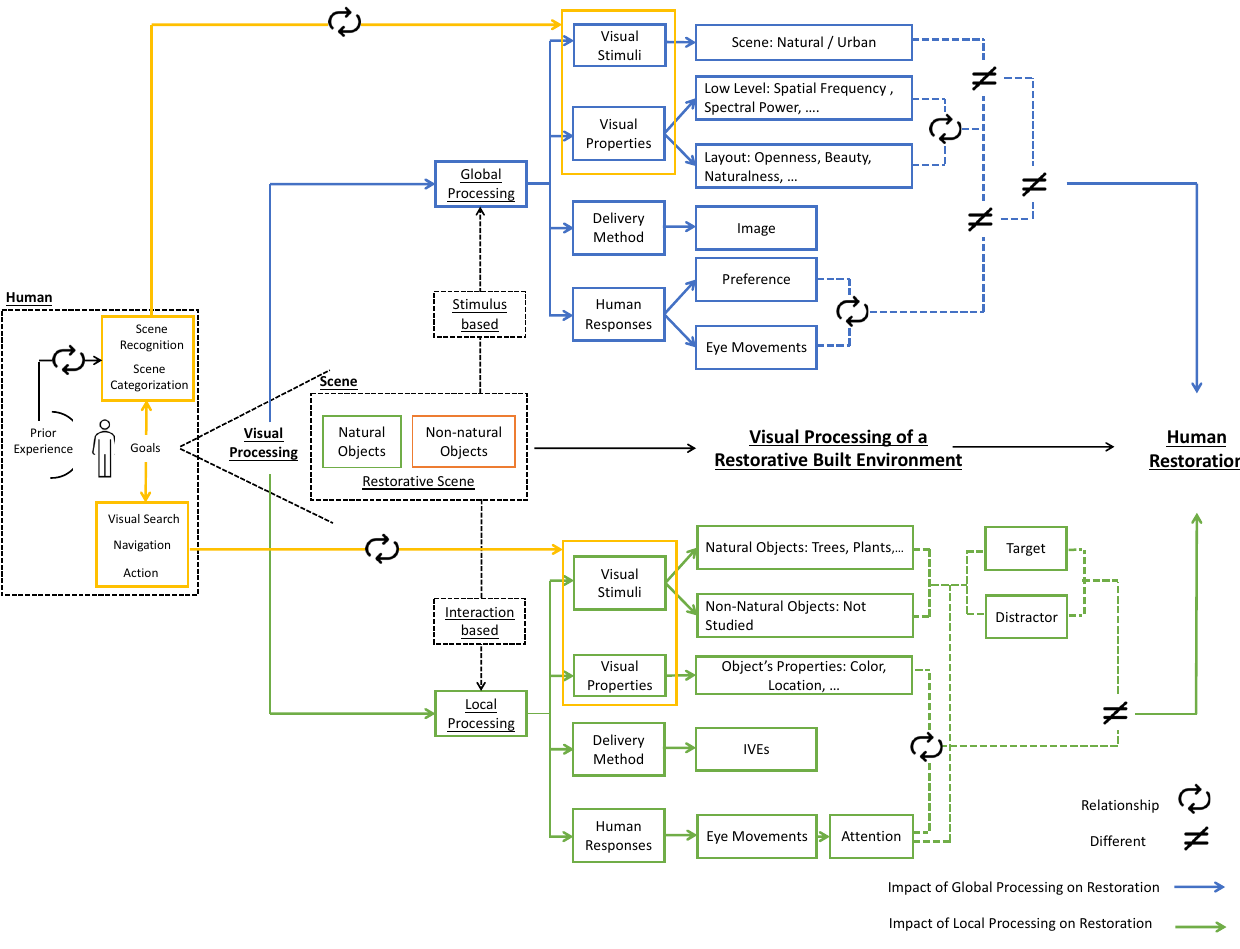
Figure 11. A Framework of visual stimuli, visual properties, and restoration.